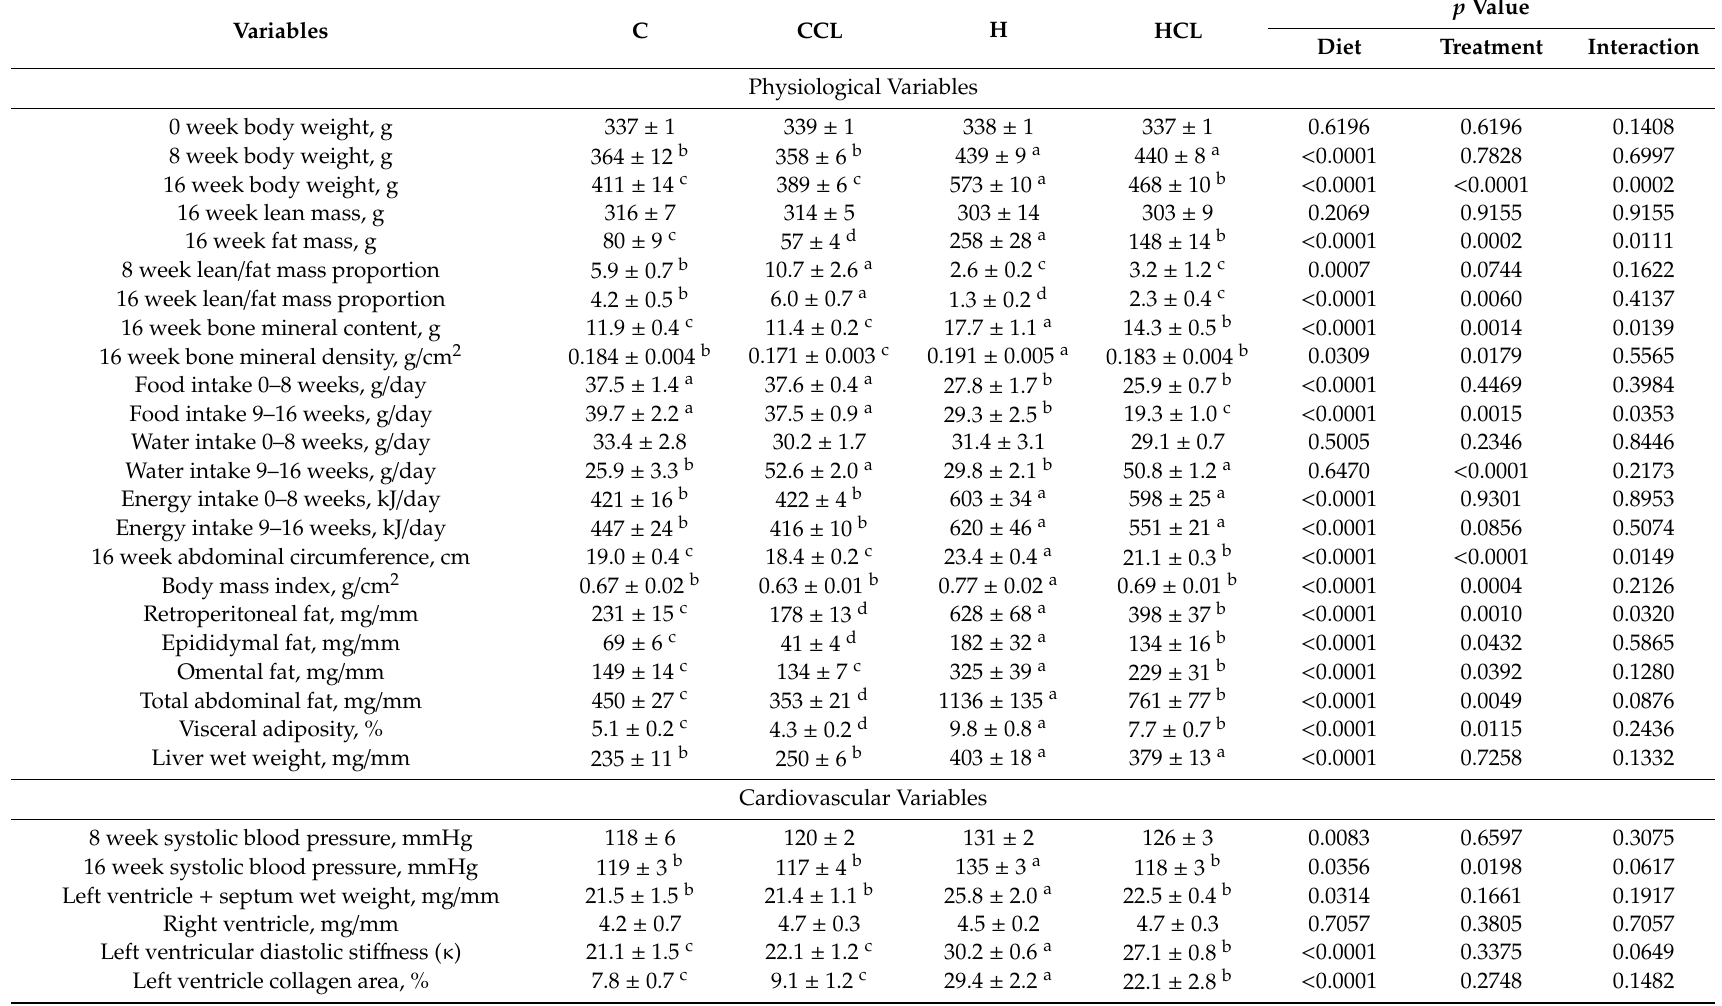
Table 2. Responses to Caulerpa lentillifera